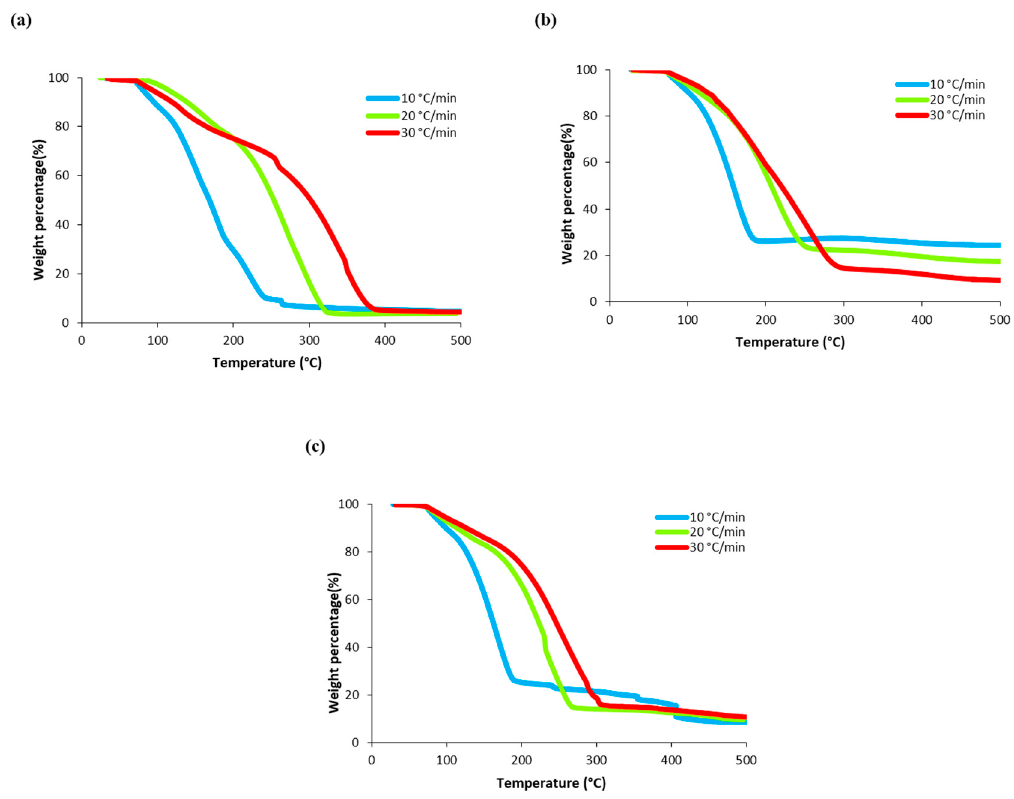
Figure 1. Thermogram (TG) of ( a ) Caulerpa lentillifera , ( b ) Gracilaria coronopifolia and ( c ) Chaetomorpha linum at three heating rates (10 °C/min, 20 °C/min and 30 °C/min).